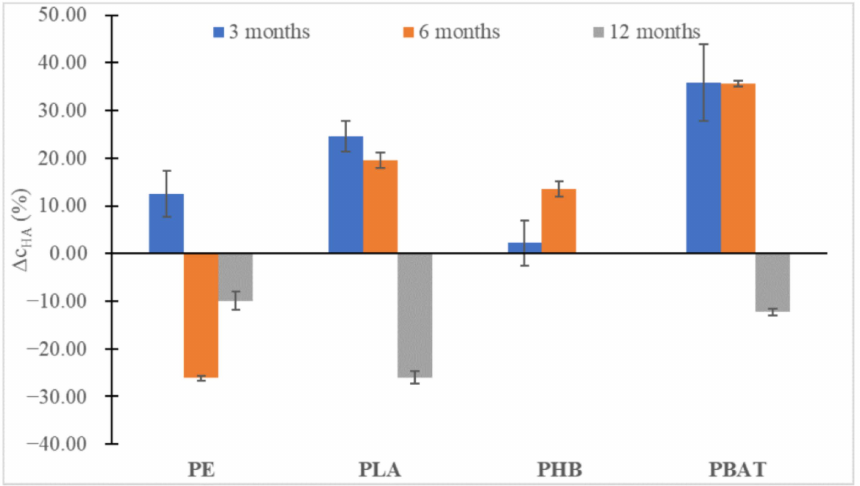
Figure 6. The percentual change in HA concentrations in the soil after 3, 6 and 12 months of incuba‑ tion relative to HA content in blank incubation.